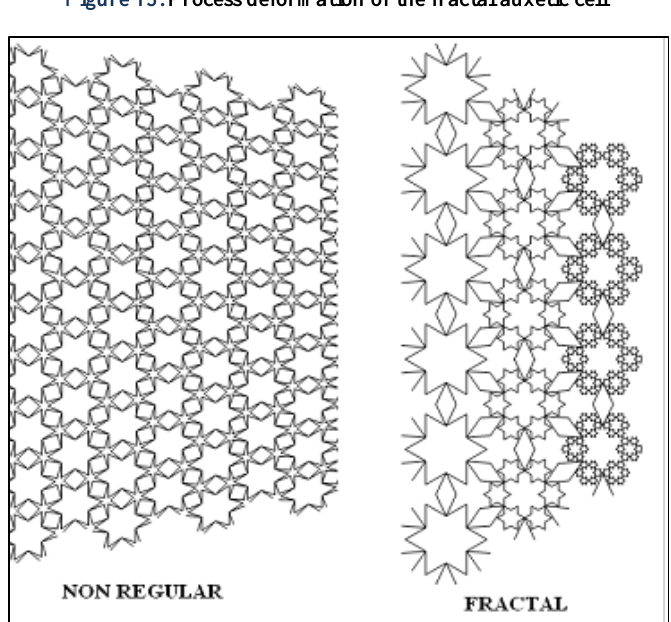
Figure 16. Dimensional variation of auxetic structure n.1 in a non-regular system or in a fractal one